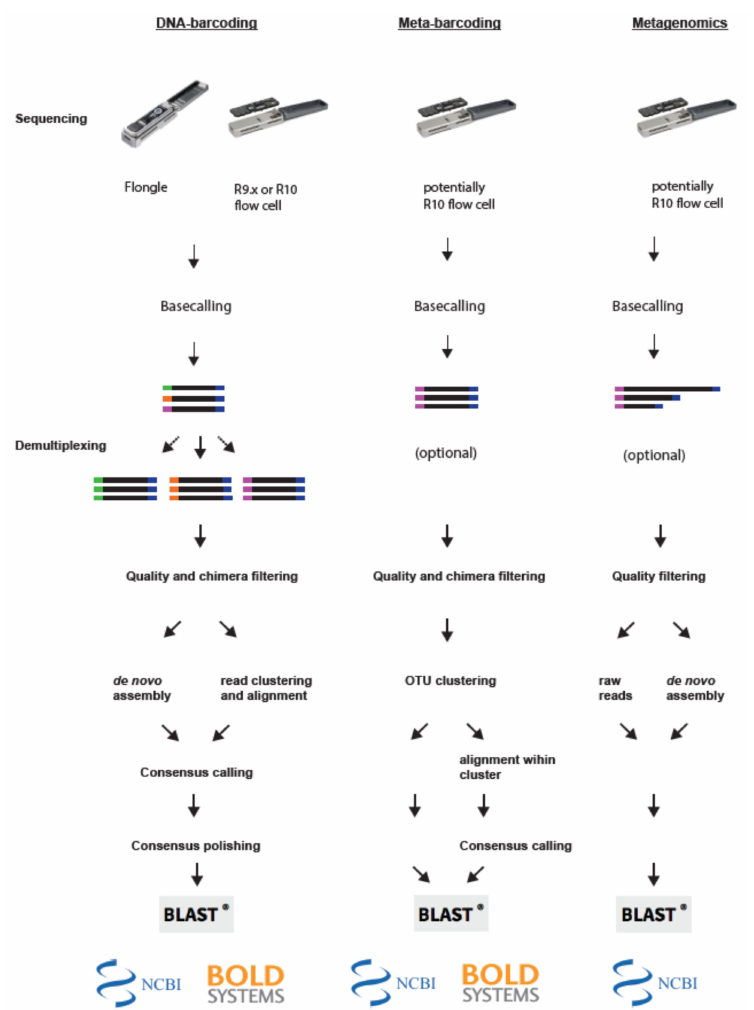
Figure 2. Principle steps of bioinformatic pipelines for MinION-based biodiversity assessment approaches. Left panel: For DNA barcoding the reads are first base-called and demultiplexed. Next reads are filtered and depending on the applied pipeline either assembled de novo, or clustered and subsequently aligned. Lastly, the consensus sequences are polished and blasted against a database. Middle panel: For Metabarcoding applications the reads are first base-called and quality filtered. Next reads are clustered into OTUs and then blasted against a database directly or aligned to create individual consensus sequences. Right panel: For metagenomic applications reads are first base-called and filtered. Subsequently, reads are either blasted against a database directly, or assembled de novo into contigs and subsequently blasted against a